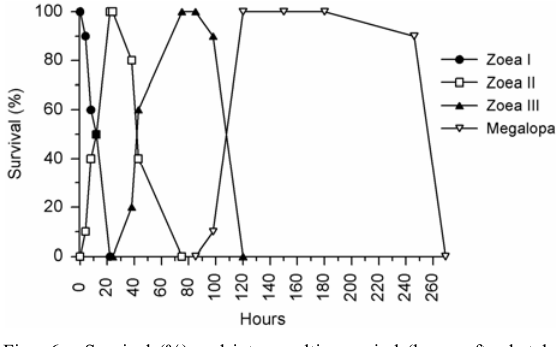
Fig. 6 – Survival (%) and intermoulting period (hours after hatch- ing) of Lepidophthalmus siriboia larvae reared in the laboratory and submitted to an initial starvation period. In this treatment, they were submitted to entire starvation (Control